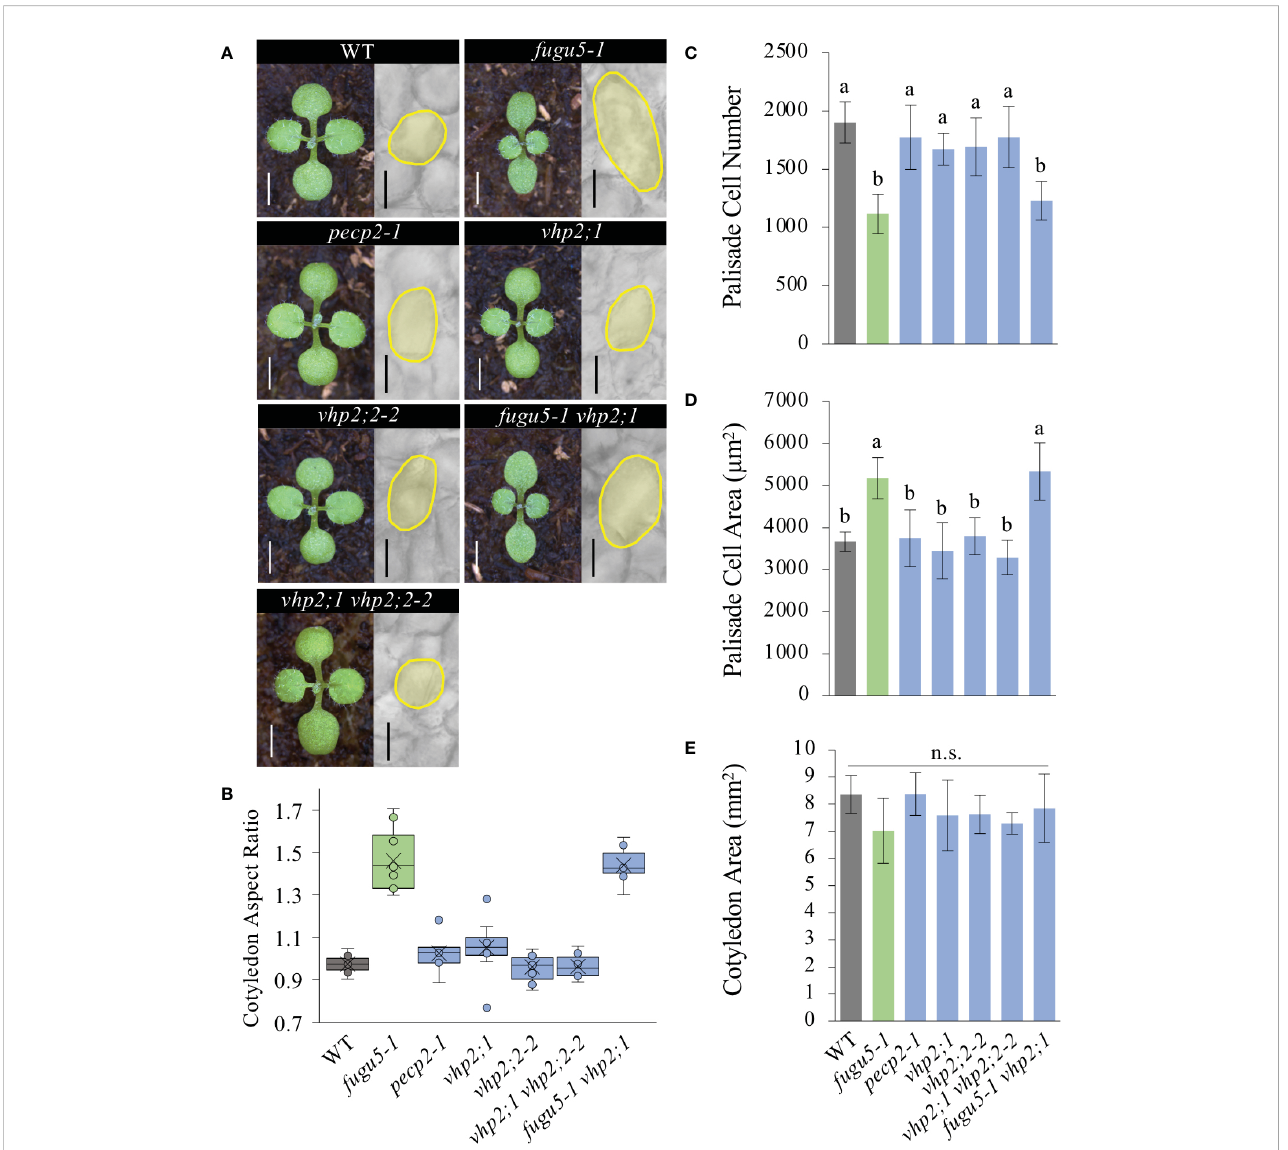
FIGURE 2 Quanti fi cation of cotyledon morphological and cellular phenotypes. (A) Gross morphology of the indicated genotypes (left), grown on rockwool for 10 DAS. Scale bar = 2 mm. Micrographs of palisade tissue cells from cleared cotyledons of WT, fugu5-1 , pecp2-1 , vhp2;1 , vhp2;2-2 , vhp2;1 vhp2;2-2 and fugu5-1 vhp2;1 lines (right), at 25 DAS. Scale bar = 50 µm. (B) Box plots of cotyledon aspect ratio at 25 DAS ( n = 8). The lower and upper portions of the boxes are the fi rst and third quartiles, respectively, and the dividing line is the median. Dots represent each value. (C – E) Numbers of subepidermal palisade tissue cells (C) , their average sizes (D) , and the average sizes of each cotyledon (E) at 25 DAS. Data are means ± SD ( n = 160 cells from eight different cotyledons). Each character represents a signi fi cant difference at P < 0.05 (Tukey ’ s HSD test). n.s., not signi fi cant. DAS, days after seed